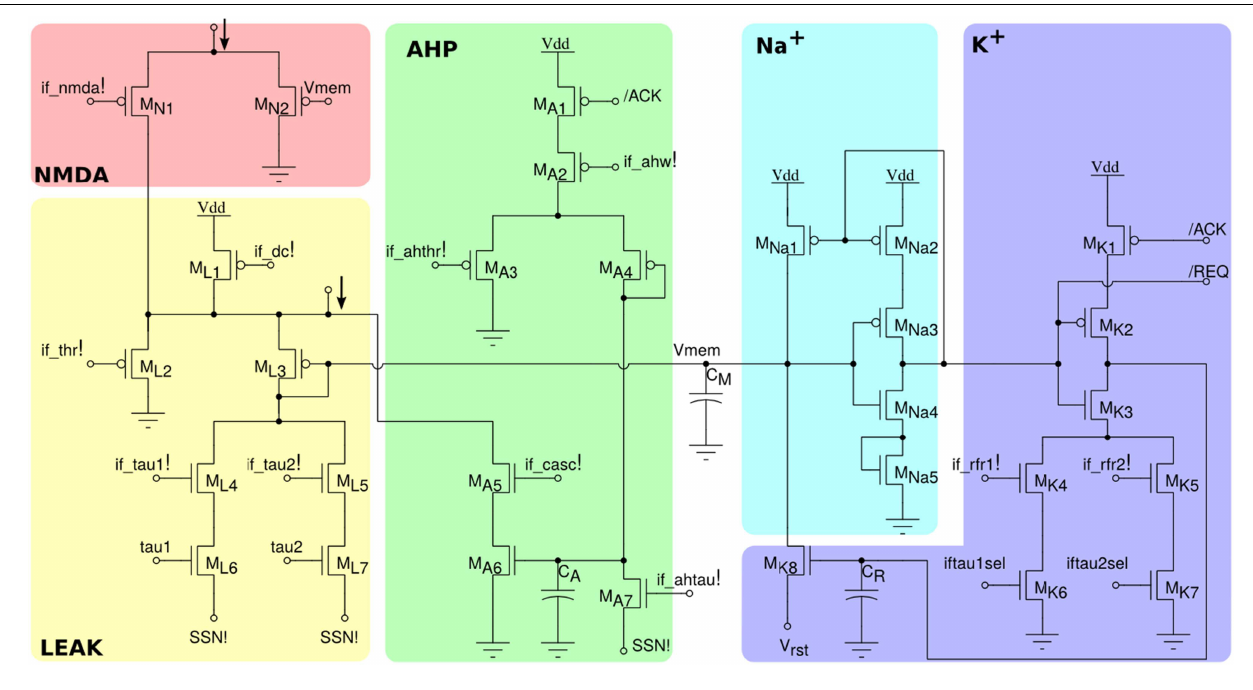
FIGURE 3 | Silicon neuron schematics. The NMDA block implements a voltage gating mechanism; the LEAK block models the neuron’s leak conductance; the spike-frequency adaptation block AHP models the